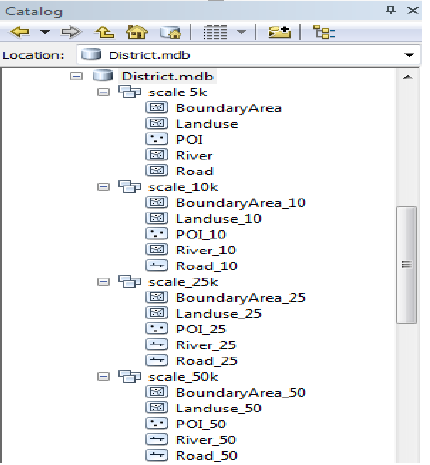
Figure 5. Multi-scale in separated database, with no connected topology/link between LoD and redundancy of attributes/geometry.